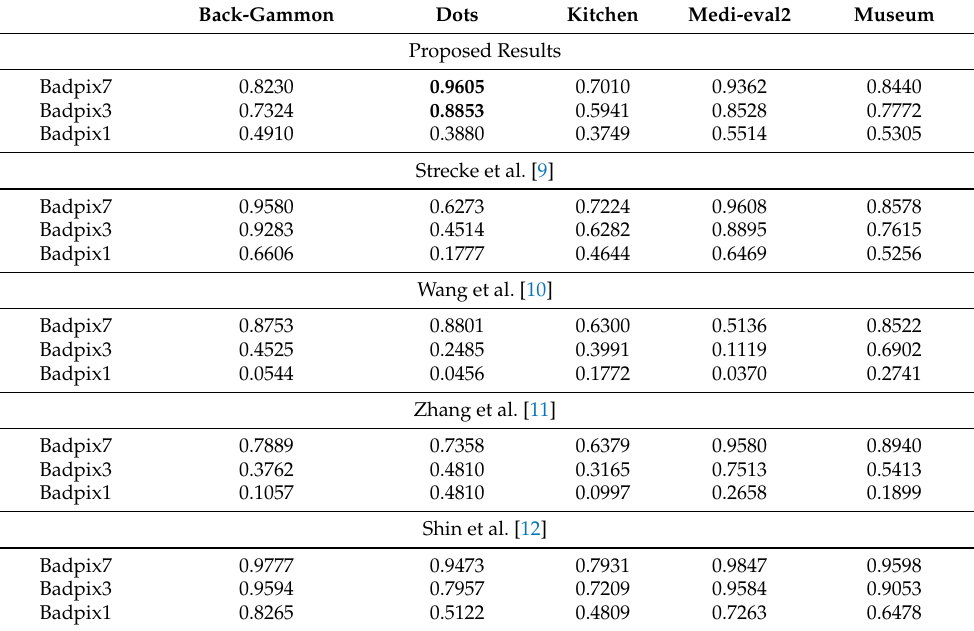
Figure 20. Visual comparison of the proposed algorithm with Strecke et al. [9], Wang et al. [10], Zhang et al. [11] and Shin et al. [12] for synthetic LF images. Table 2. Quantitative depth map comparison for synthetic data to ground truth for different